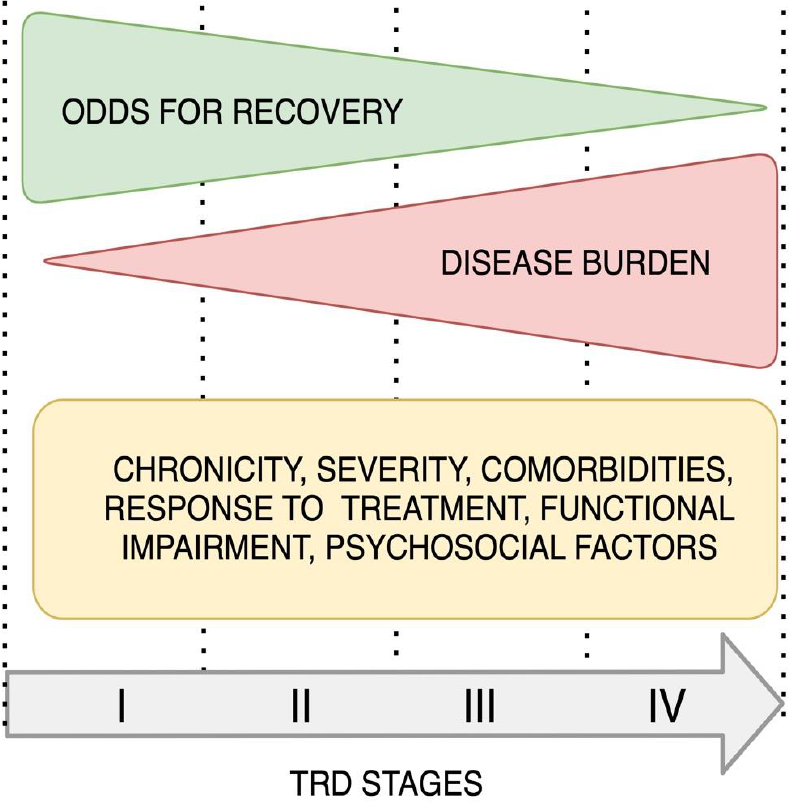
Figure 1. The progressive course of TRD. Modified from Fekadu et al. 2009, van Belkum et al. 2018. TRD (treatment-resistant depression) [24,25].